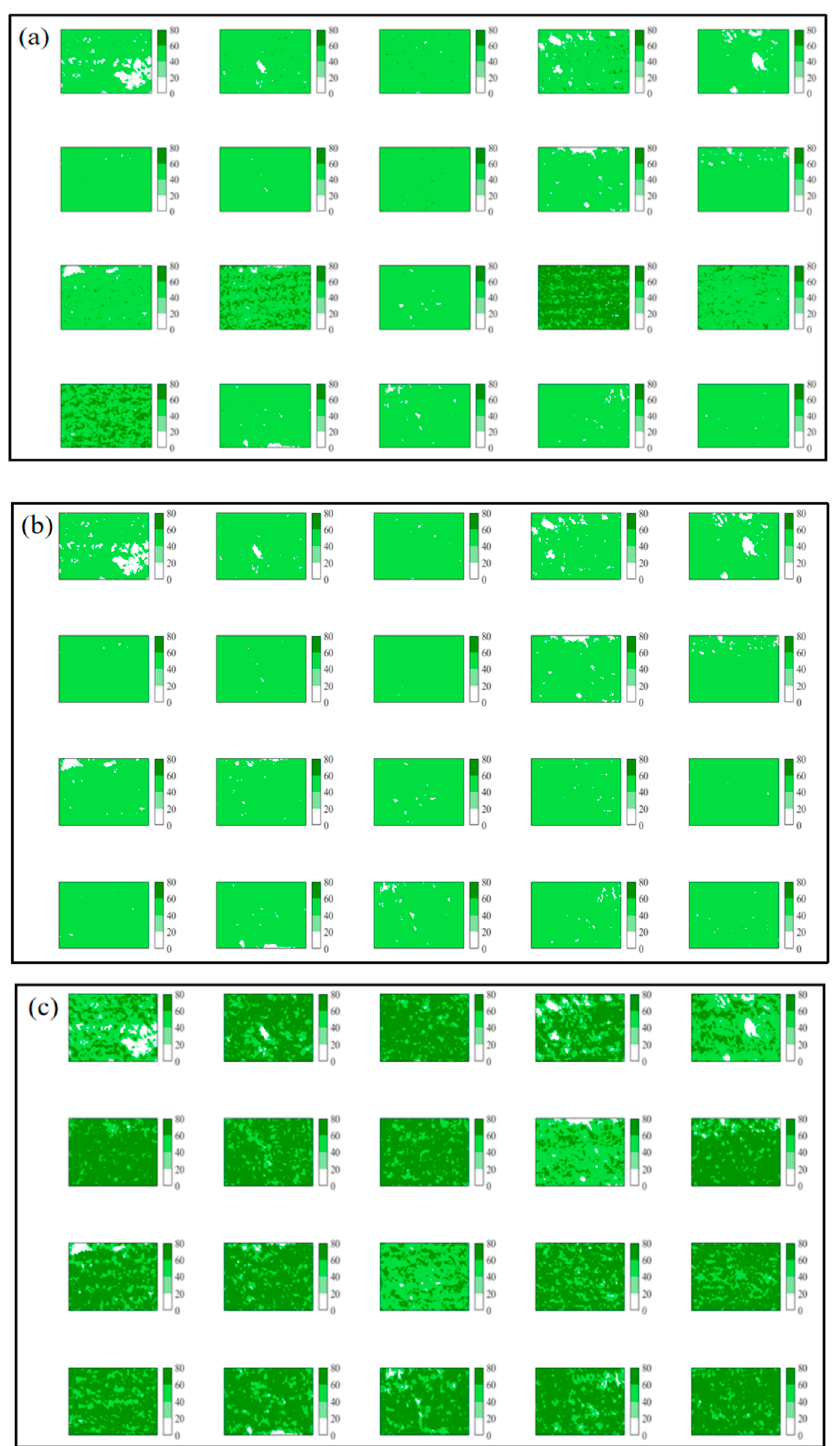
Figure A4. The predicted chlorophyll contents values using BP, SVM, and RF models using images acquired on 8 July 2019. ( a – c ) represented the predicted chlorophyll contents using BP, SVM, and RF, respectively.